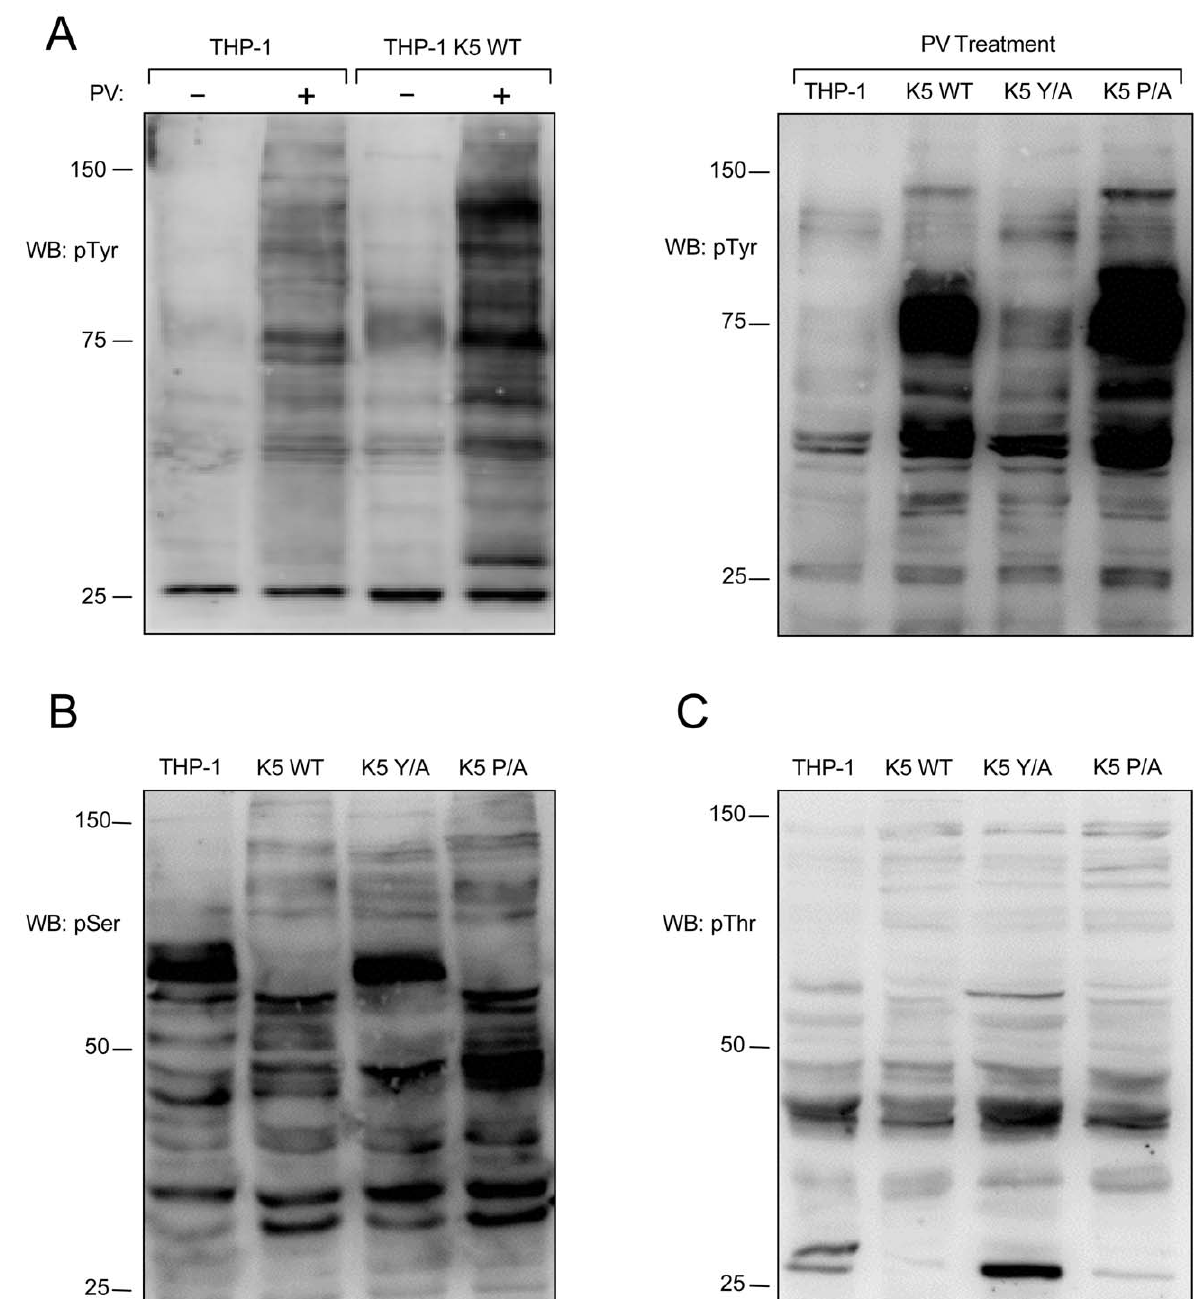
Figure 4. K5 alters tyrosine, serine and threonine phosphorylation. ( A, left panel ) Vector- and K5 WT-expressing THP-1 cells were mock (-) or pervanadate (PV) treated for ten minutes and normalized whole cell lysates were subjected to western blot (WB) using an anti-phospho-tyrosine (4G10) (pTyr) antibody. Normalized whole cell lysates from PV treated THP-1 cell lines, as indicated, were subjected to western blot using ( A, right panel ) anti-phospho-tyrosine (4G10) (pTyr), ( B ) anti-phospho-serine (pSer) or ( C ) anti-phospho-threonine (pThr) antibodies. Data for all panels are representative of three independent experiments. doi:10.1371/journal.ppat.1001331.g004 medium and reduced lactate production on a per cell basis (data (Fig. 5A). Examination of the impact of sunitinib on cell growth not shown). produced less clear results. Incubation of vector- or K5- expressing THP-1 with 2 m M sunitinib in 2%FBS resulted in a As an additional validation of the RTK array data, identified nearly equivalent average increase in doubling time, 1.33 fold receptors were examined individually in THP-1 cell lines. First, (28.8 hrs to 38.4 hrs) and 2.06 fold (21.3 hrs to 39.6 hrs), normalized WCL of the THP-1 lines, treated with PV and 10% respectively (data not shown). Interestingly, however, we also FBS for ten minutes post overnight serum starvation, were subjected to immunoprecipitation (IP) using a Flt-3 antibody observed that treatment with sunitinib blocked acidification of the